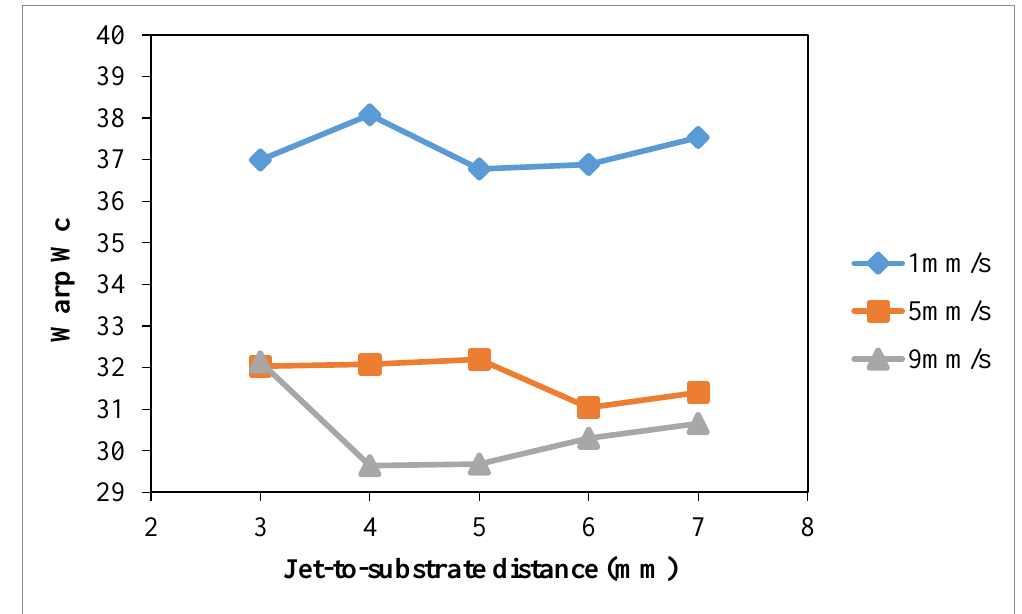
Figure 14. Effect of jet-to-substrate distance on warp W c (Jet-to-substrate distance: 3 mm, 4 mm, 5 mm, 7 mm and 9 mm; Jet travelling speed: 1 mm/s, 5 mm/s, 9 mm/s; Discharge power: 150 W and Oxygen flow rate: 0.4 L/min).